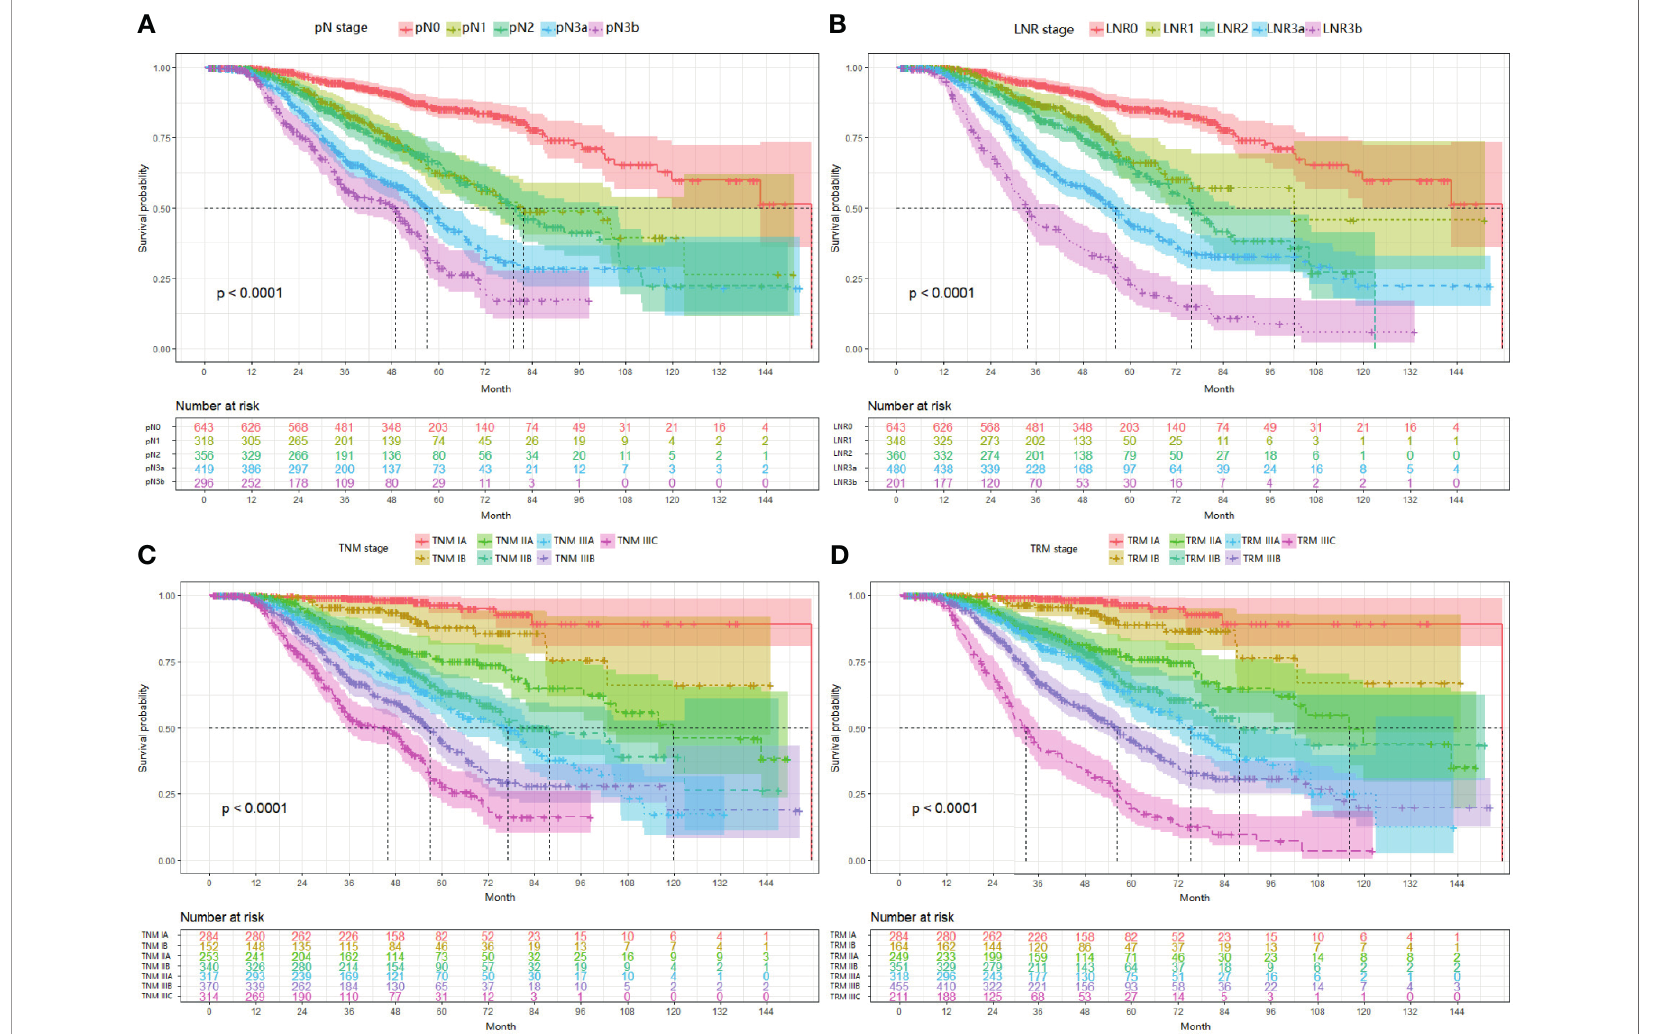
FIGURE 1 | Impact of the pN (A) , LNR (B) , TNM (C) , and TRM (D) staging on OS in training set. (A) pN stage: pN0 vs pN1, p < 0.001; pN1 vs pN2, p = 0.546; pN2 vs pN3a, p < 0.001; pN3a vs pN3b, p < 0.001; (B) LNR stage: LNR0 vs LNR1, p < 0.001; LNR1 vs LNR2, p = 0.010; LNR2 vs LNR3a, p < 0.001; LNR3a vs LNR3b, p < 0.001; (C) TNM staging system: IA vs IB, P = 0.006; IB vs IIA, p = 0.004; IIA vs IIB, p = 0.016; IIB vs IIIA, p = 0.101; IIIA vs IIIB, p = 0.001; IIIB vs IIIC, p < 0.001; (D) TRM staging system: IA vs IB, p = 0.020; IB vs IIA, p = 0.001; IIA vs IIB, p = 0.185; IIB vs IIIA, p = 0.024; IIIA vs IIIB, p < 0.001; IIIB vs IIIC, p < 0.001. LNR, lymph node ratio; TNM, tumor – node – metastasis; TRM, tumor – ratio –